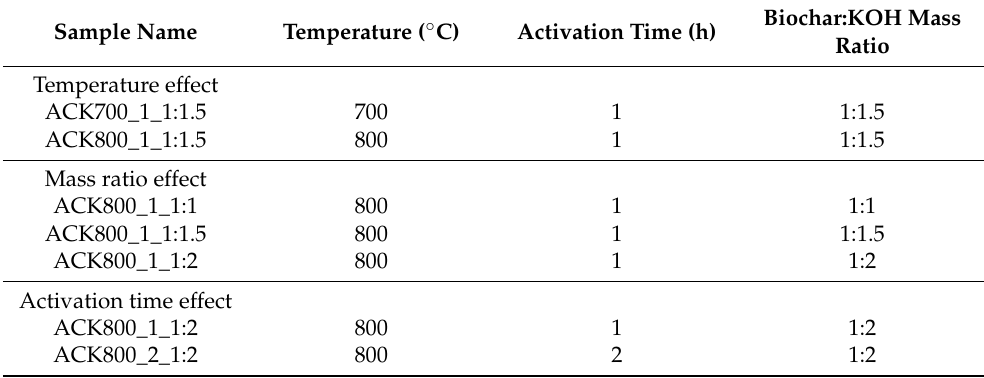
Table 1. Experimental design for porous carbons synthesis and nomenclature of